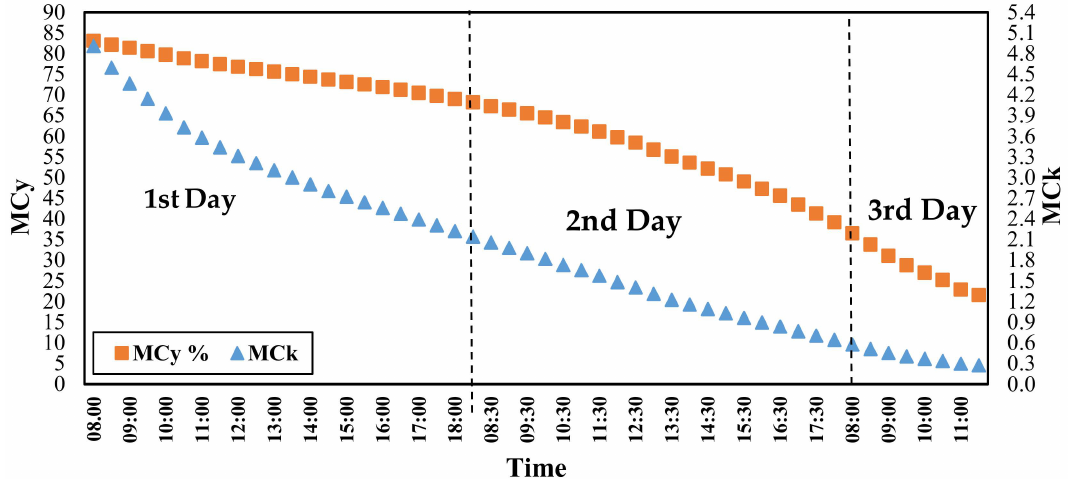
Figure 6. Variation of moisture content values with time.